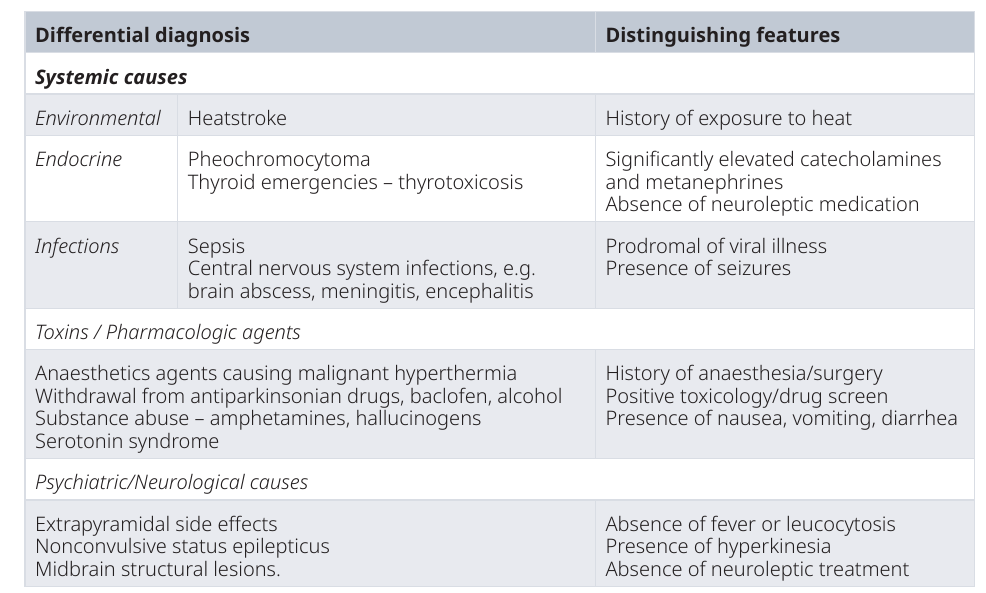
Table 3. Differential diagnosis and distinguishing features of neuroleptic malignant